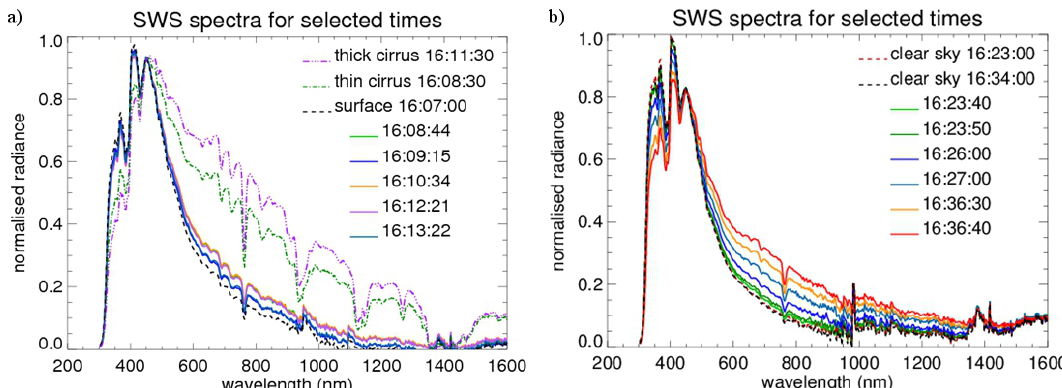
Fig. 8. (a) SWS (nadir geometry) spectra shown for the times during RUN 1 when contrails were sampled (solid lines) and for when cirrus was sampled (dashed lines). (b) SWS (zenith geometry) spectra shown for times during Run 2 when contrails were sampled (solid lines) and for when clear sky was sampled (dashed lines). Both plots are normalised to 450nm wavelength.